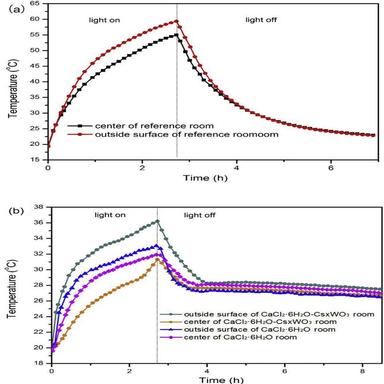
Central and outside surface temperature variation curves of the testing chambers with different kinds of windows. (a) Reference room (b) PCM room with and without nanoparticles.